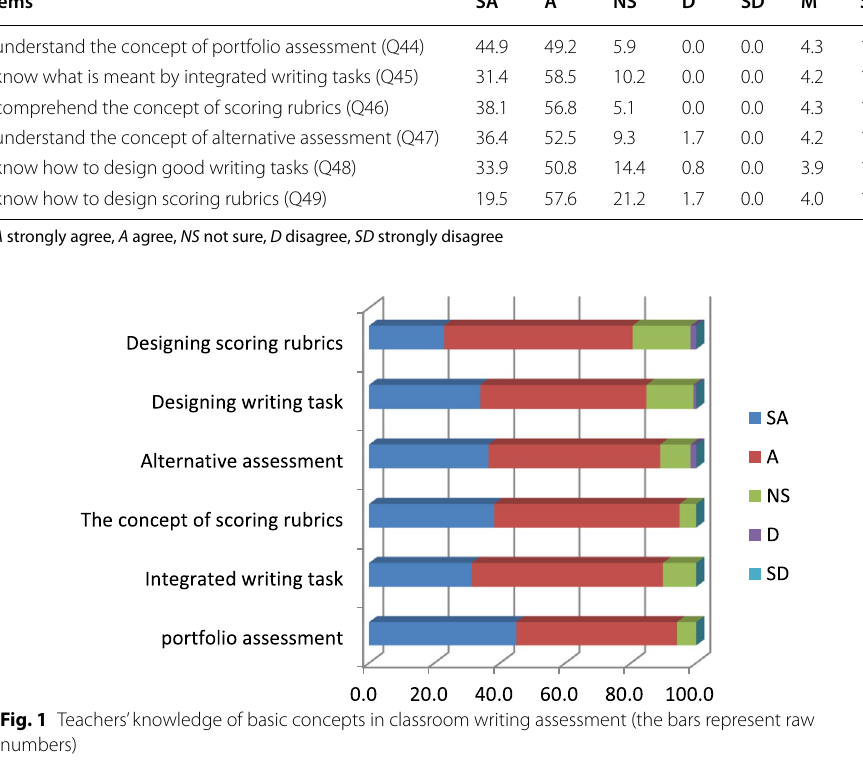
Table 2 Teachers’ knowledge of basic concepts of classroom writing assessment